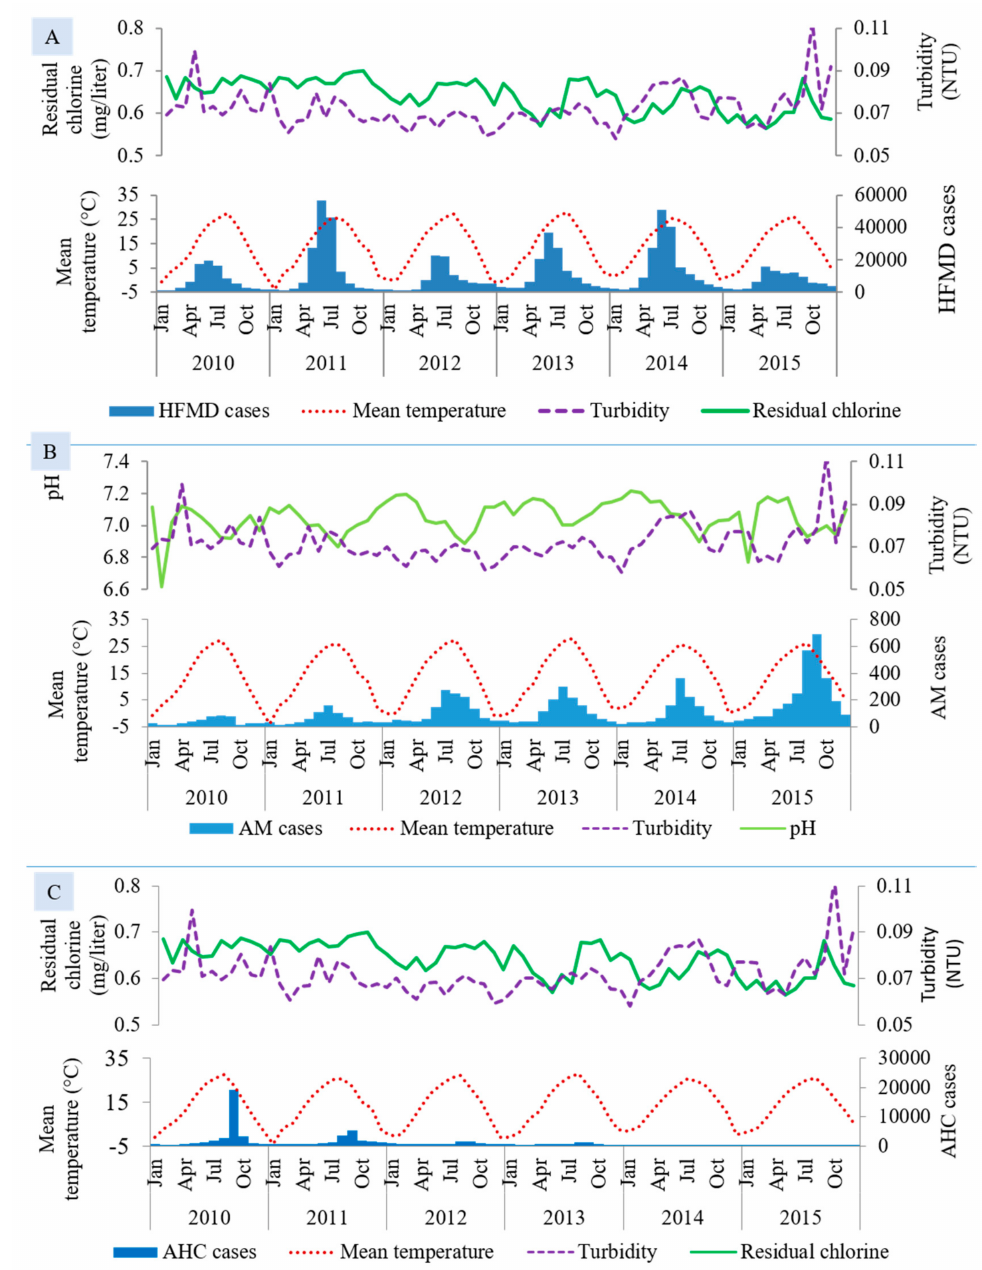
Figure 2. Monthly and yearly distributions of ( A ) HFMD, ( B ) AM, and ( C ) AHC cases with environmental factors in seven metropolitan provinces of Korea from 2010 to 2015.